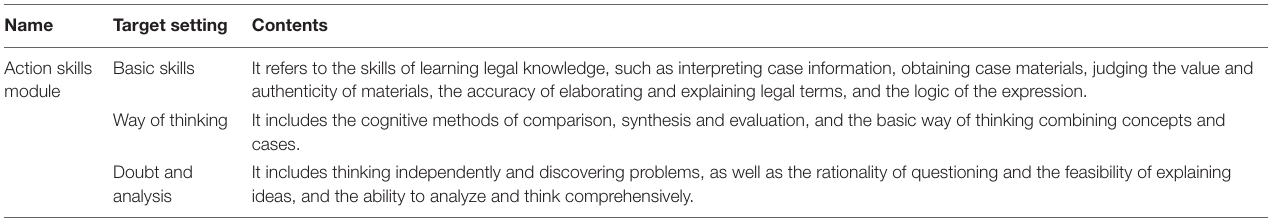
TABLE 4 | Contents of action skills